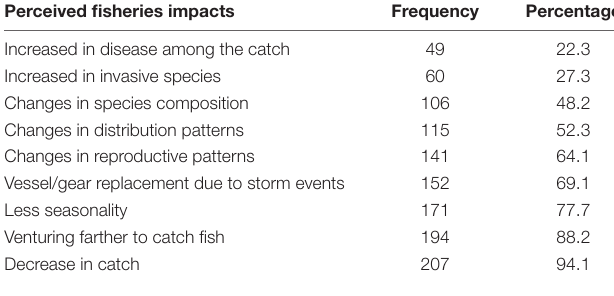
TABLE 3 | Perceived impacts to fishers.